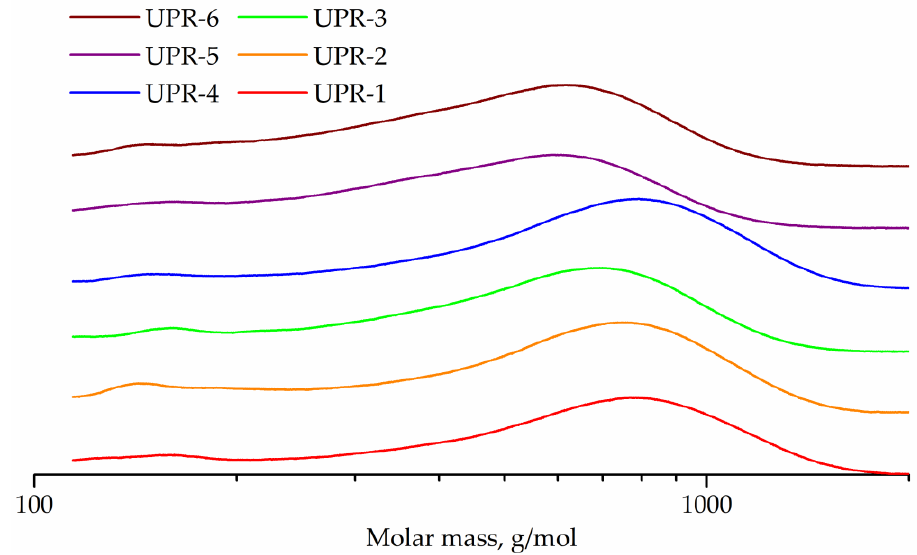
Figure 11. GPC curves of UPR-1, UPR-2, UPR-3, UPR-4, UPR-5, and UPR-6 samples. The conversion cannot be calculated, because the reactions of glycolysis of OEPT-1, ODEEPT-1, and OPEPT-1 oligoesters and polycondensation of diethylene or 1,2-propylene glycols and maleic anhydride occur simultaneously in this process. Molecular weight characteristics of samples of UPRs are shown in Table 5.